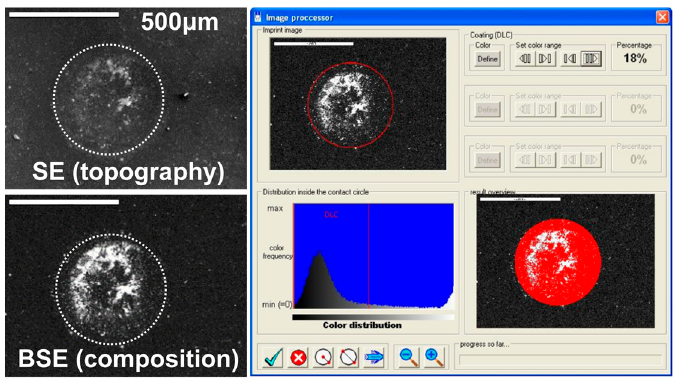
Figure 11. Evaluation of SEM backscattered electron analysis photos via image processing to determine failed area ratio (FR).